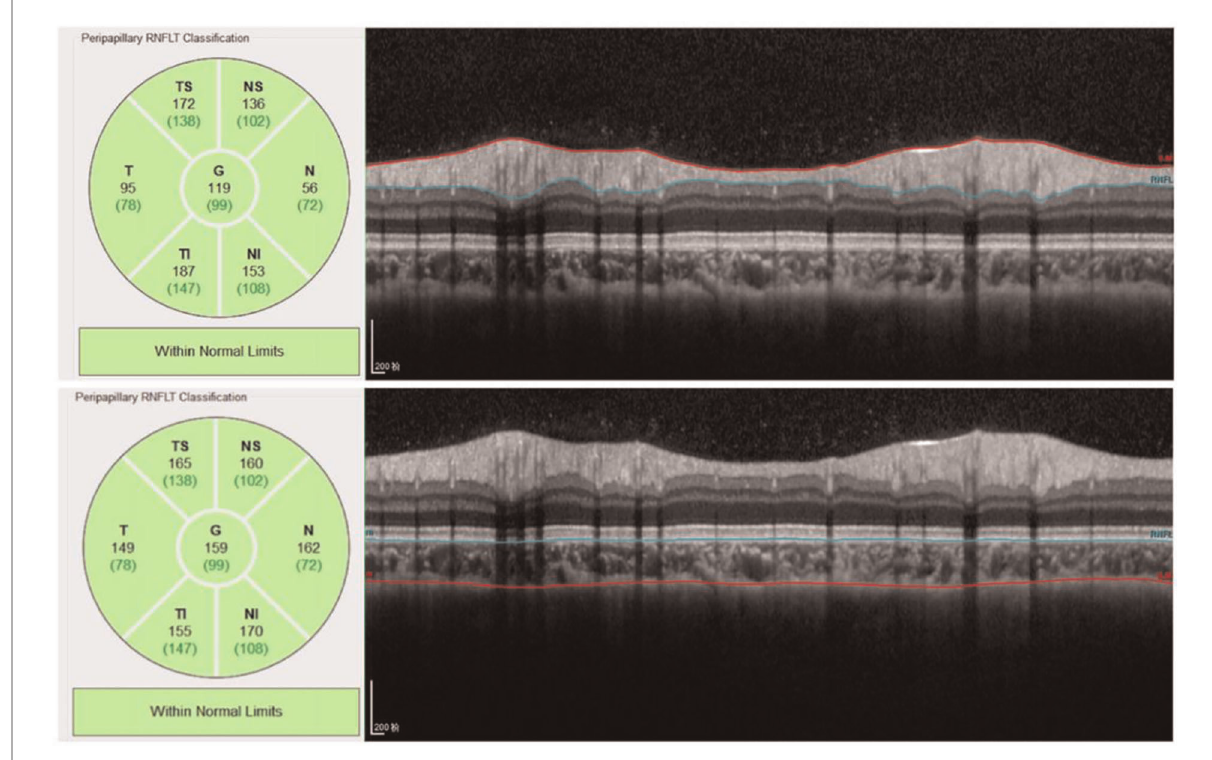
FIGURE 3 Peripapillary RNFL and choroidal thickness measurement. The RNFL thickness data can be automatically calculated and displayed. For peripapillary choroidal thickness measurement, we manually moved the automatically segmented internal limiting membrane line to the choroid sclera junction and moved RNFL line to the retina pigment epithelial line. Once we changed the automatically segmented line, the choroidal thickness data were automatically calculated and